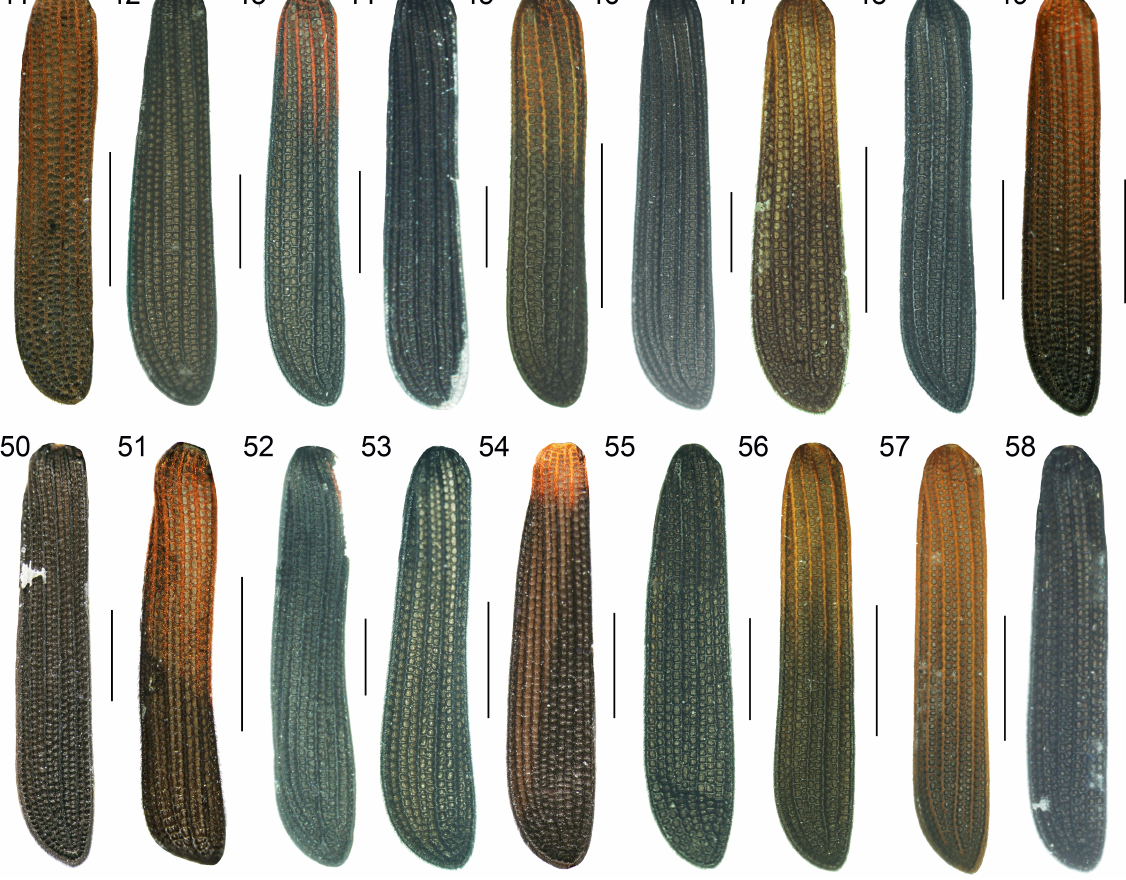
Figs 41–58. Male elytra. 41 . Cautires alexae sp. nov. 42 . C. andujari sp. nov. 43 . C. arribasae sp. nov. 44 . C. berembanensis sp. nov. 45 . C. campestris sp. nov. 46 . C. communis sp. nov. 47 . C. griseus kleine, 1930. 48 . C. jasarensis sp. nov. 49 . C. katarinae sp. nov. 50 . C. kirstenae sp. nov. 51 . C. kotatinggensis sp. nov. 52 . C. linardi sp. nov. 53 . C. maseki sp. nov. 54 . C. pahangensis sp. nov. 55 . C. nervosus kleine, 1926. 56 . C. renatae sp. nov. 57 . C. reverandi Pic, 1925. 58 . C. simillimus kleine, 1926. scale bars = 1.0